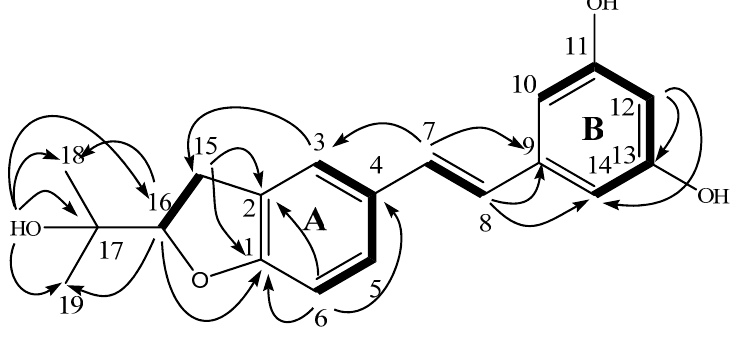
Figure 2. Key 1 H- 1 H COSY and HMBC correlations of 1 and 2 . Table 1. NMR spectroscopic data for compound 1 (DMSO- d 6 ) a .